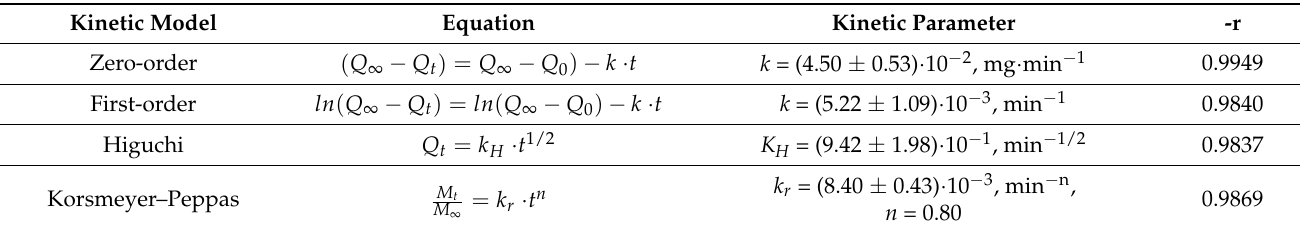
Table 1. Kinetic study for CS permeation from the eye drops (CS 20.2 mg/mL, HA 0.4%) through a hydrophilic membrane made of regenerated cellulose (Visking ® ).